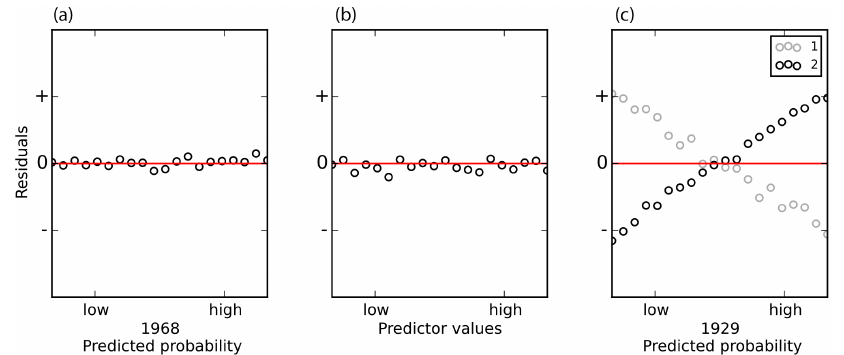
Figure 9. Hypothetical output of hillslope failure conditional probability analysis for the 1929 and 1968 earthquakes. This illustrates how the model residuals (observed P LS minus predicted P LS ) would be distributed if conditional probability models, which account for the full subset of spatial, time-independent factors (i.e. those not associated with previous events) influencing landslide occurrence, have been fitted and used to hindcast P LS . (a) 1968 model residuals are uncorrelated with predicted P LS . (b) Model residuals are uncorrelated with values of individual model predictors. (c) Model residuals are correlated with P LS hindcast for the 1929 earthquake either negatively (model 1) – indicating preconditioning of hillslopes against failure – or positively (model 2) – indicating preconditioning of hillslopes for failure. The residuals are calculated by aggregating probabilities across equal quantile bins of the x variable. Note that positive and negative residuals are relative to the prediction of a model that does not explicitly consider the effect of hillslope preconditioning but is fitted using landslide data that are subject to the effect of hillslope preconditioning. Therefore it is the direction of the trend, rather than the absolute (positive or negative) residual values, that is of importance in the test of